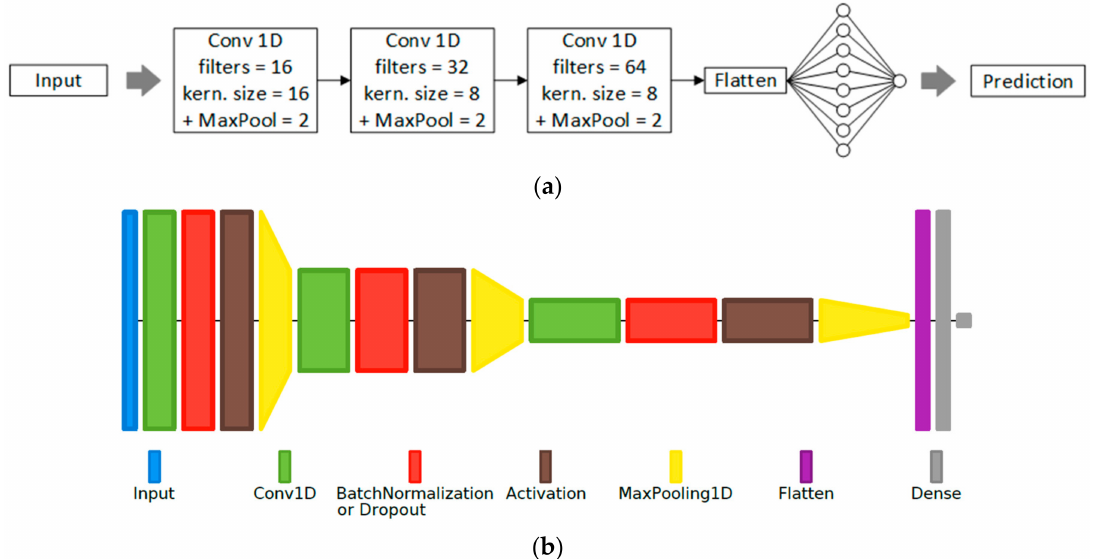
Figure 1. CNN-based VAD system. In this configuration example, the three convolutional (Conv) layers use 16, 32, and 64 filters, respectively, with corresponding kernel sizes of 16, 8, and 8. The size of the max-pooling layers used after the Conv layers is 2. The third Conv layer’s output is flattened into a one-dimensional vector and fed through a fully connected hidden layer with 8 nodes, used together with the output neuron with the “sigmoid” activation function for final frame-level classification. ( a ) Block diagram representation; ( b ) Layer diagram representation using Net2Vis [33].